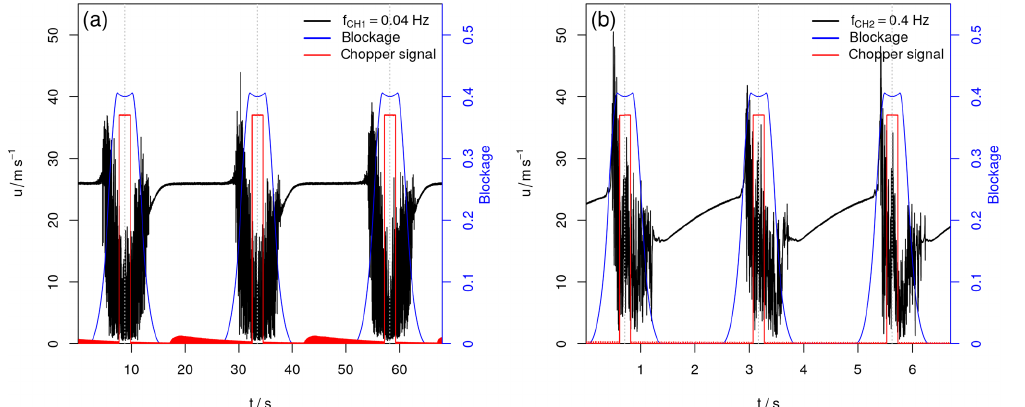
= 0 . 04Hz, (b) f = CH 2 1